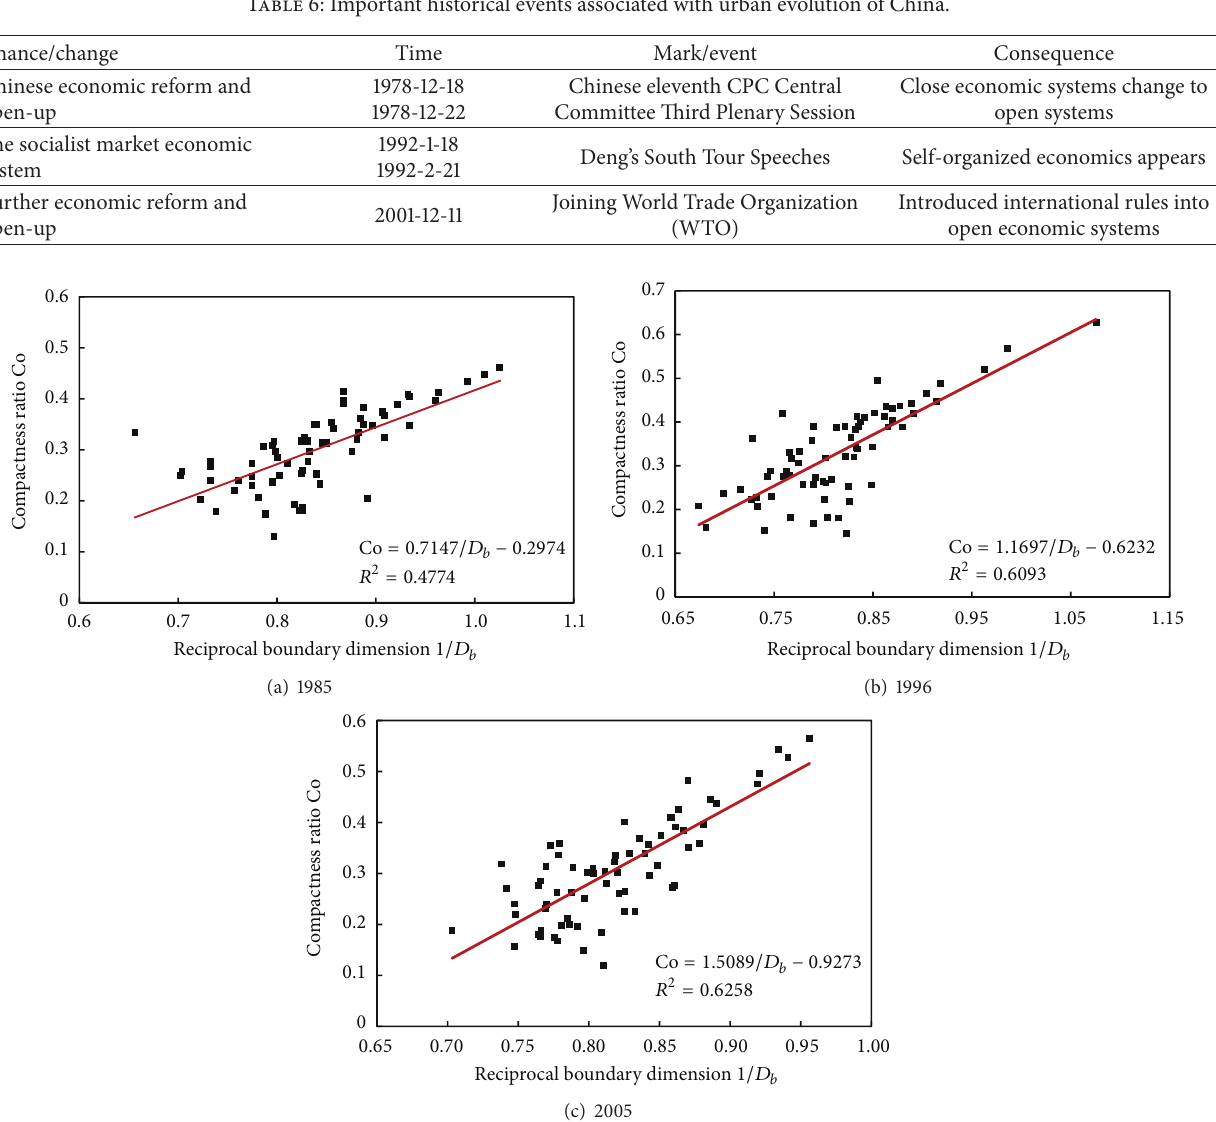
Figure 3: The relationships between reciprocal of the boundary dimension and the compactness ratio of the cities and towns in Yangtze River Delta, China (1985–2005) [note: for 1985, the fractal dimension of Deqing is less than 0 and is removed as an